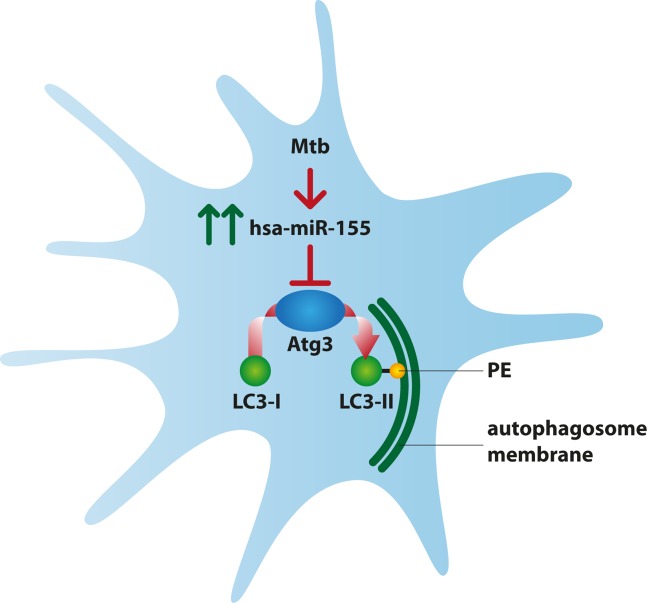
Model for Mtb-triggered inhibition of Atg3 activity.Mtb infection of human primary DC causes the strong induction of hsa-miR-155 expression. The de-regulated miR-155 interacts with the 3’UTR region of the ATG3 mRNA, leading to a reduced protein level. As a consequence, an impaired LC3 conversion into its lipidated form (LC3-II) through the addiction of the phosphatidylethanolamine (PE) was observed in Mtb-infected DC.